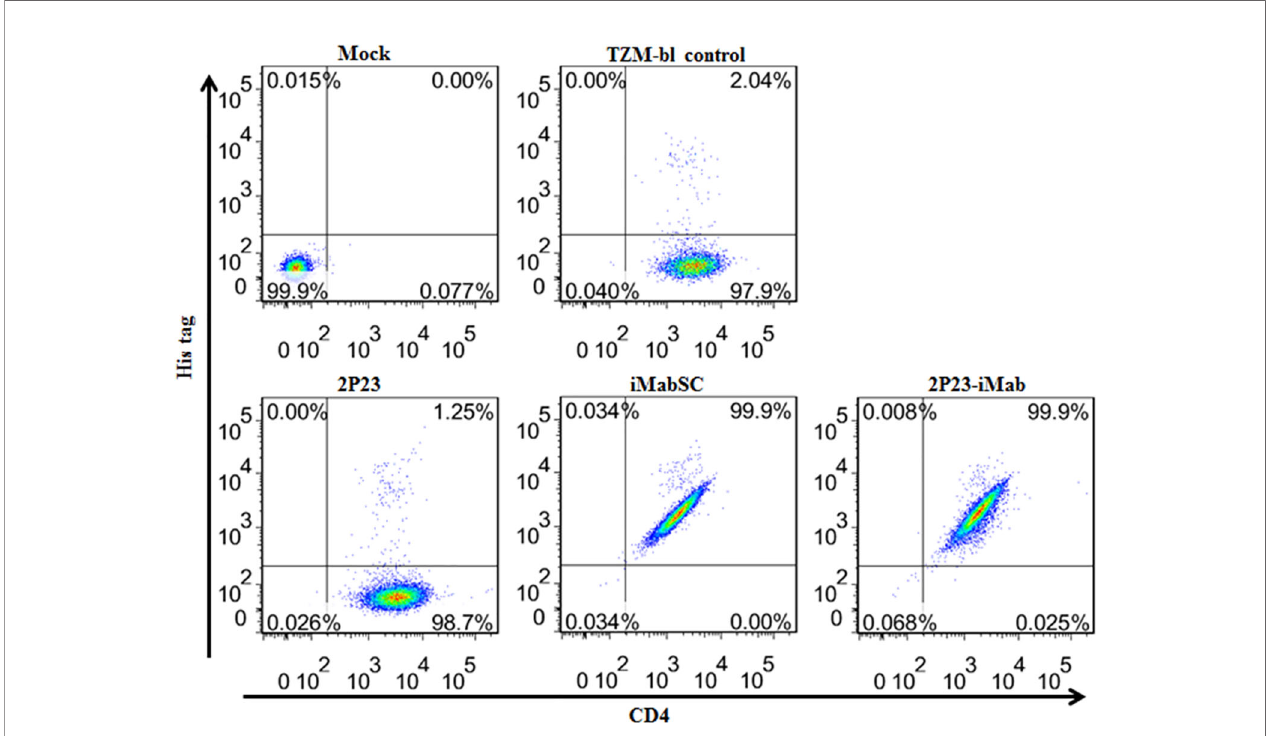
FIGURE 3 | Binding abilities of iMabSC and 2P23-iMab with the target cell membrane determined by fl ow cytometry. TZM-bl cells were preincubated with an inhibitor for 1 h and washed thoroughly to remove unbound molecules. The binding of inhibitors was then determined by mouse anti-His tag and anti-CD4